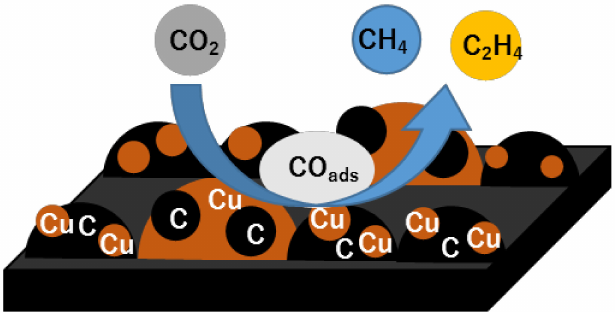
Figure 10. Reaction mechanism of the electrochemical reduction of CO 2 at Cu and Cu 2 O-deposited carbon black electrode.